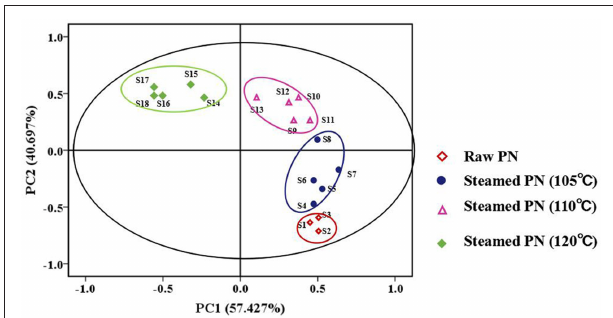
FIGURE 2 | The clustering result of the fingerprints of Panax notoginseng (PN) samples by PCA.